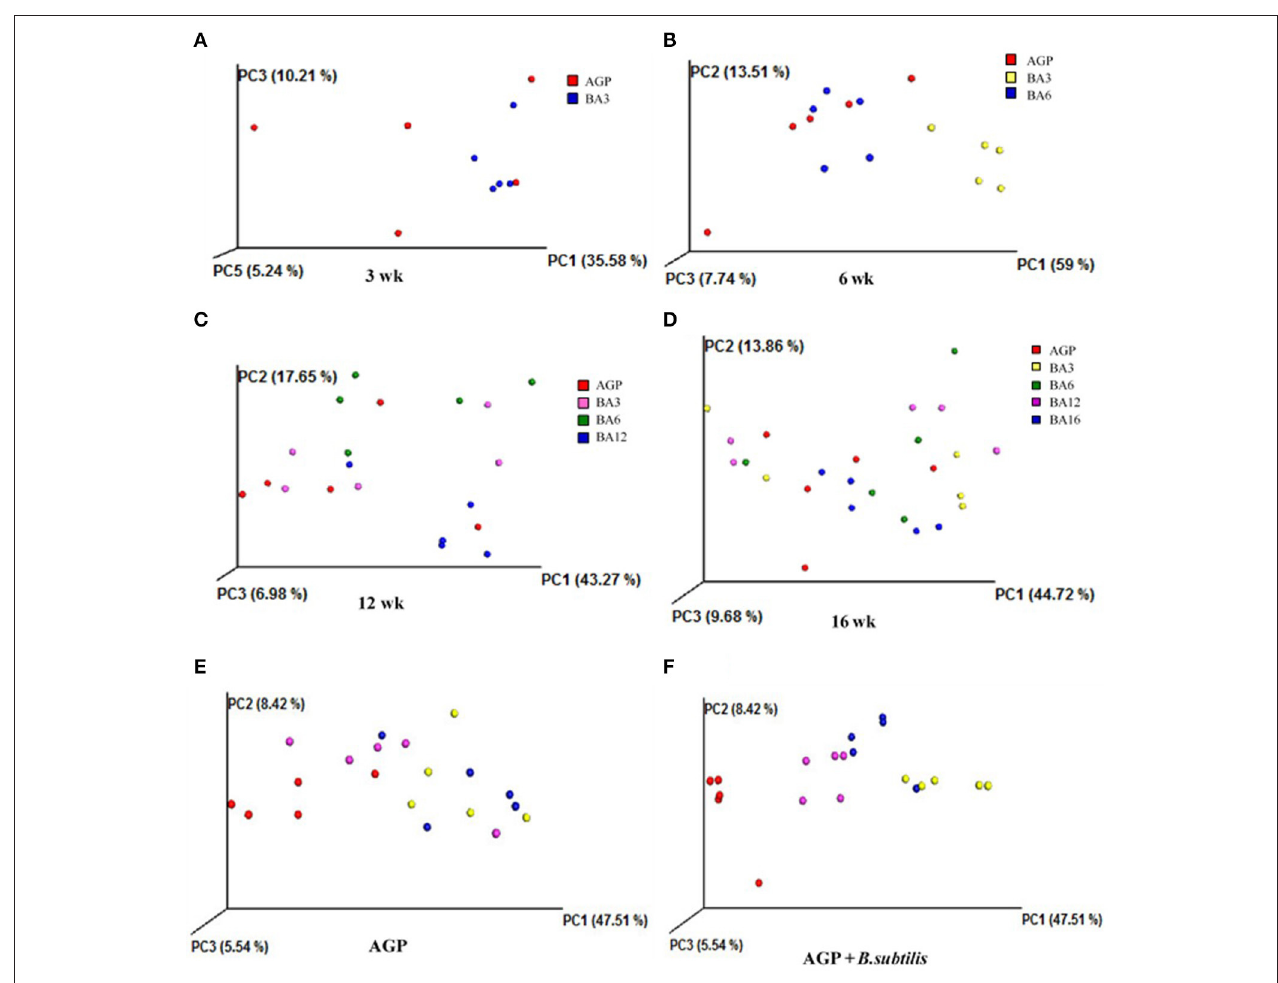
FIGURE 2 | Principal component analysis (PCoA) plots based on treatments of pullets from 0 to 16 week-age. The plots represent the samples, and the different colors represent treatments. (A) PCoA plots for treatments at week 3; (B) PCoA plots for treatments at week 6; (C) PCoA plots for treatments at week 12; (D) PCoA plots for treatments at week 16; (E) PCoA plots in AGP group for bird ages; (F) PCoA plot in AGP + B. subtilis group for bird ages.